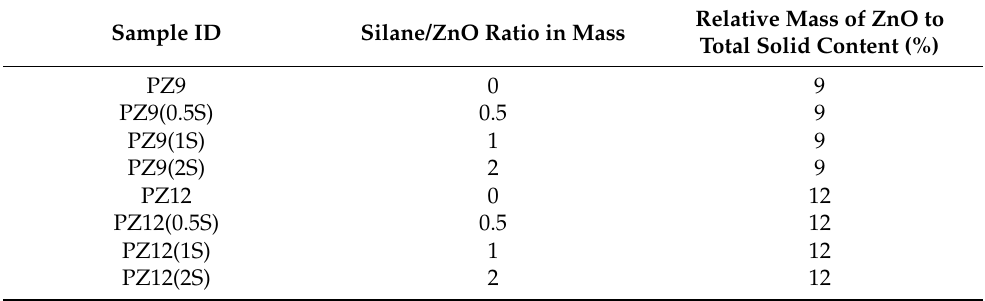
Table 1. Recipe of electrospinning solutions for PAN/ZnO silane composites. Sample